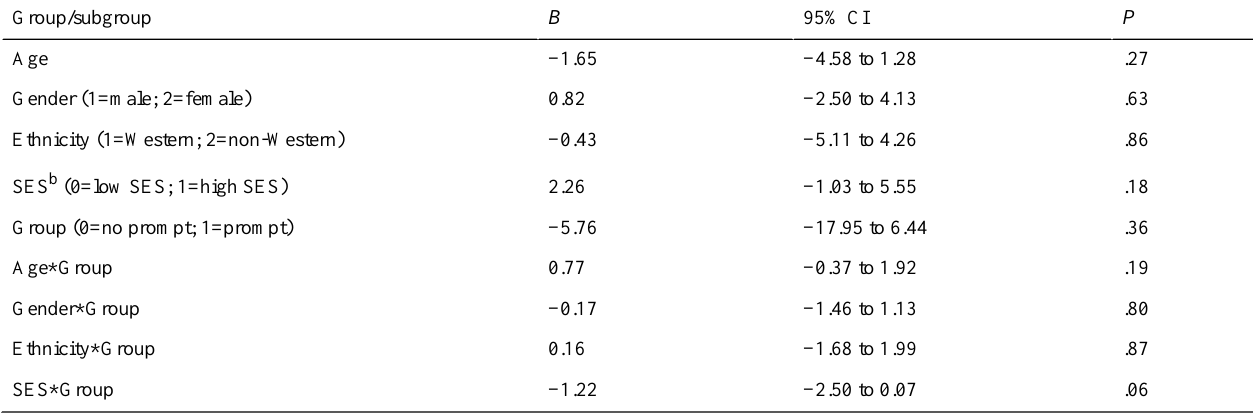
Table 3. Interaction effects between subgroups and group on reuse of the intervention website a .